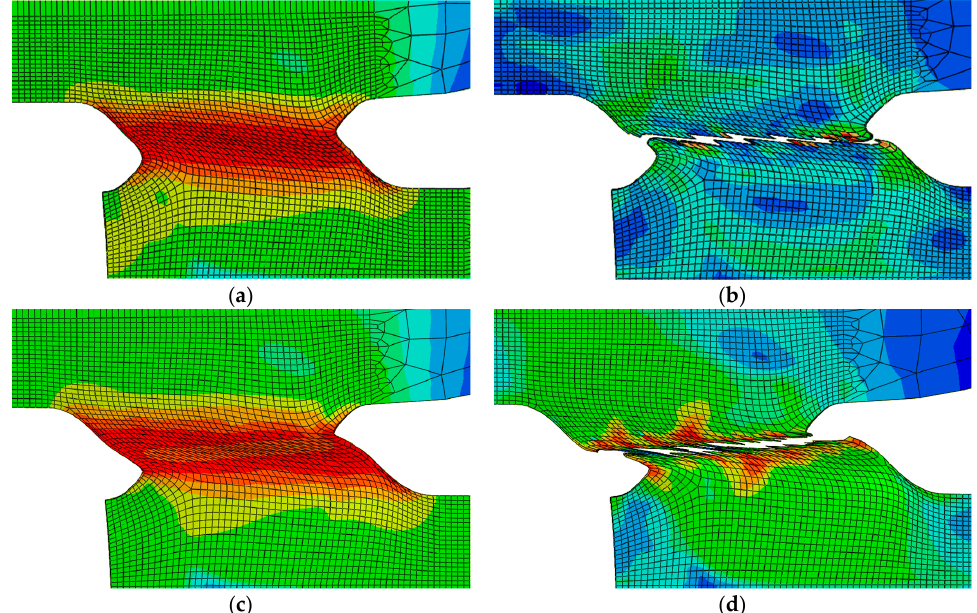
Figure 19. Results of the SYM-Shear − 45 ◦ specimen obtained using the modified N-VG model: ( a ) Stress contour and deformation of the hotspot region (u f eq = 0); ( b ) fracture path (u f eq = 0); ( c ) stress contour and deformation of the hotspot region (u f eq = 0.6); ( d ) fracture path (u f eq = 0.6). It can be seen from the data in Table 4 that the error of the maximum load P max between numerical results using the modified N-V model and the test results is within 10%, and the error of the displacement at the maximum load δ max is almost within